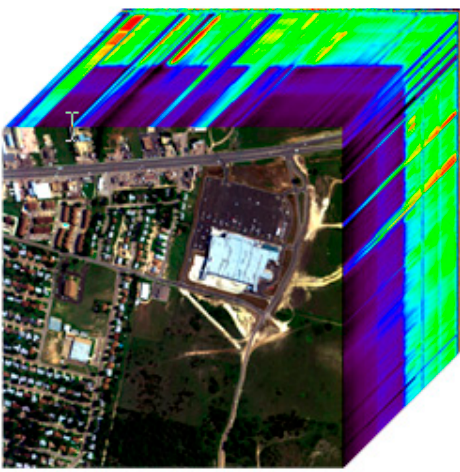
Figure 6. 3D-cube of Urban hyperspectral data set.